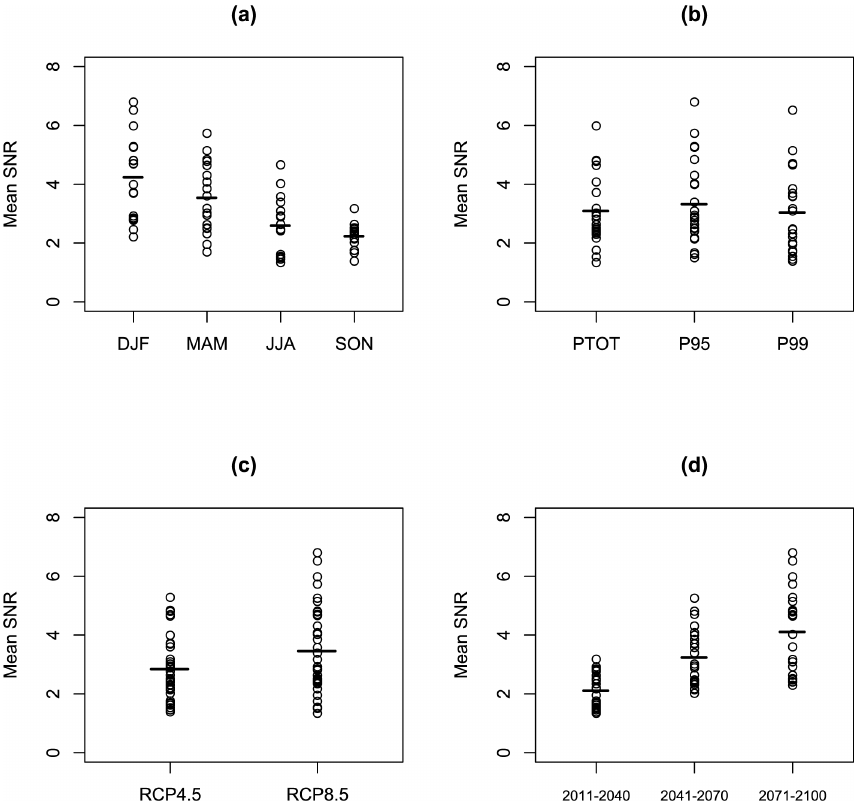
Figure 2. Each panel shows 72 values of the spatial average SNR (black circles) derived from each of the 72 EURO-CORDEX climate change projections described in the text, along with means within each sub-set (horizontal lines). Panel (a) shows the 72 values as a function of season, panel (b) shows them as a function of rainfall variable, panel (c) shows them as a function of RCP, and panel (d) shows them as a function of time